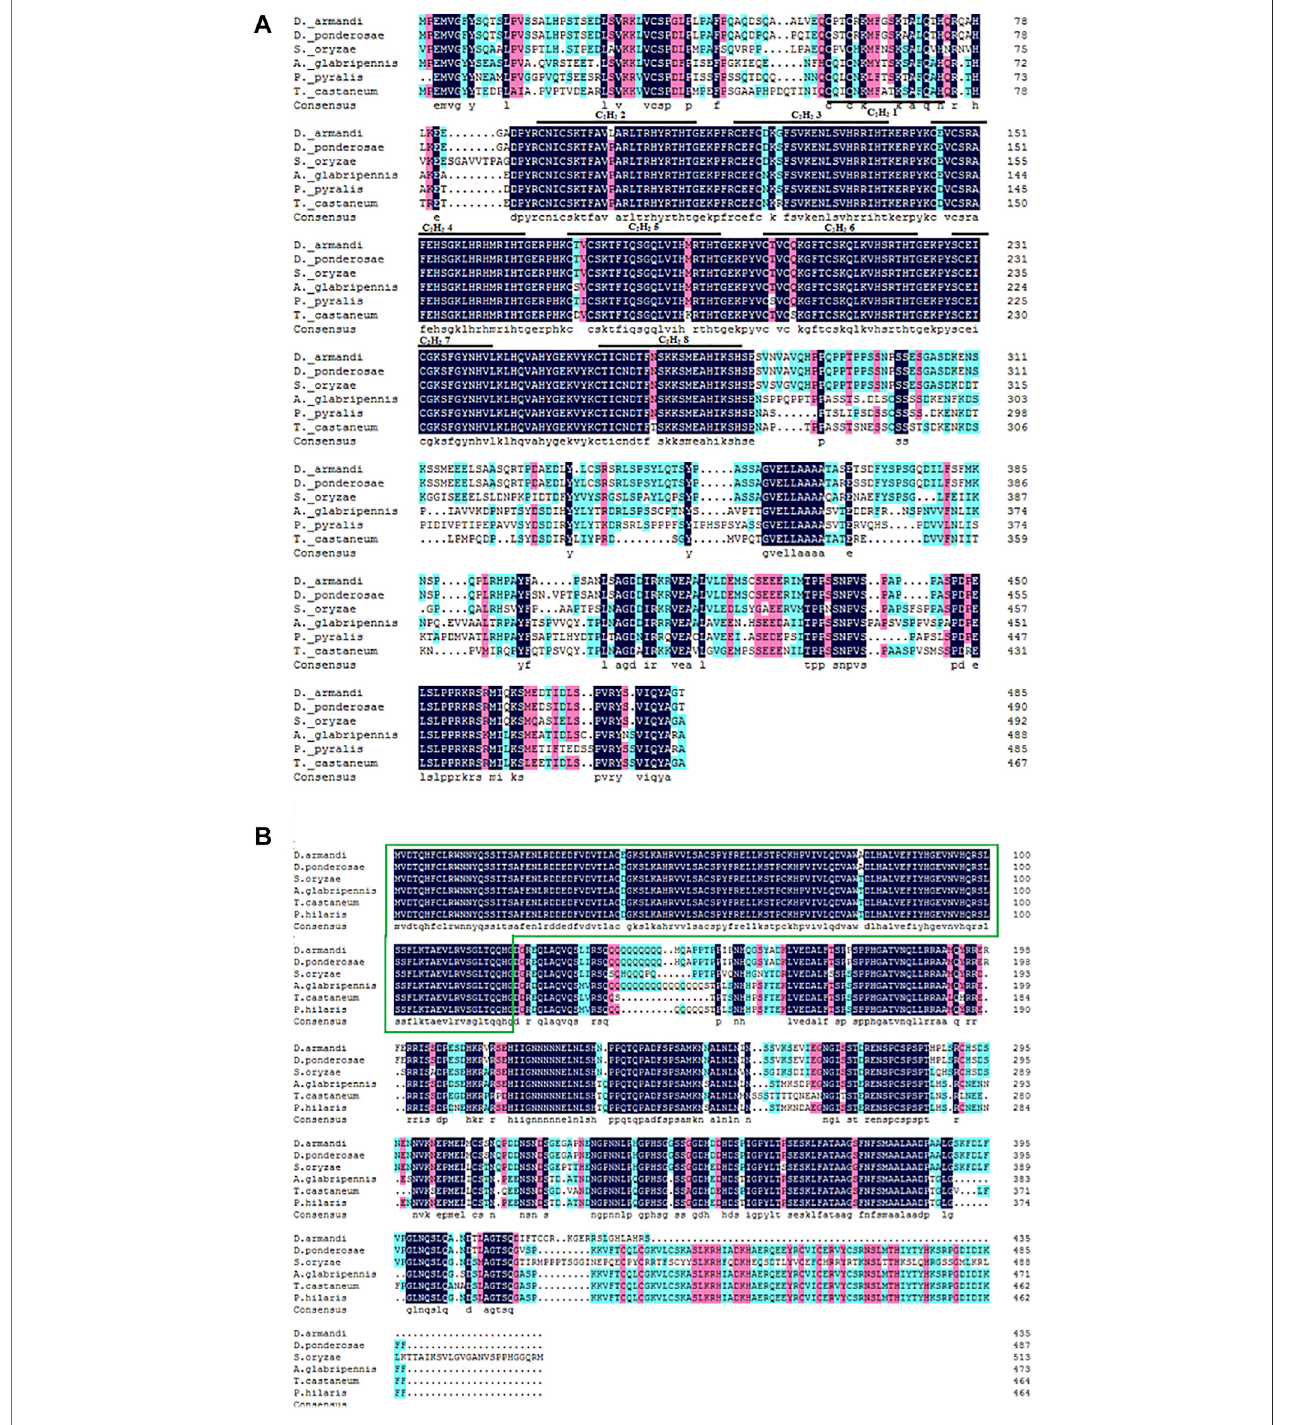
FIGURE 1 | Structures of DaKr-h1 and DaBr-C in D. armandi . (A) Alignment of the putative DaKr-h1 sequence in beetle species and their consensus sequences with D. armandi identi fi ed sequences. Black lines represent zinc fi nger structures C 2 H 2 1 – 8, marked with numbers 1 – 8, respectively. (B) Alignment of the DaBr-C sequence. The green box represents the Bric-a-brac – Tramtrack – Broad complex.